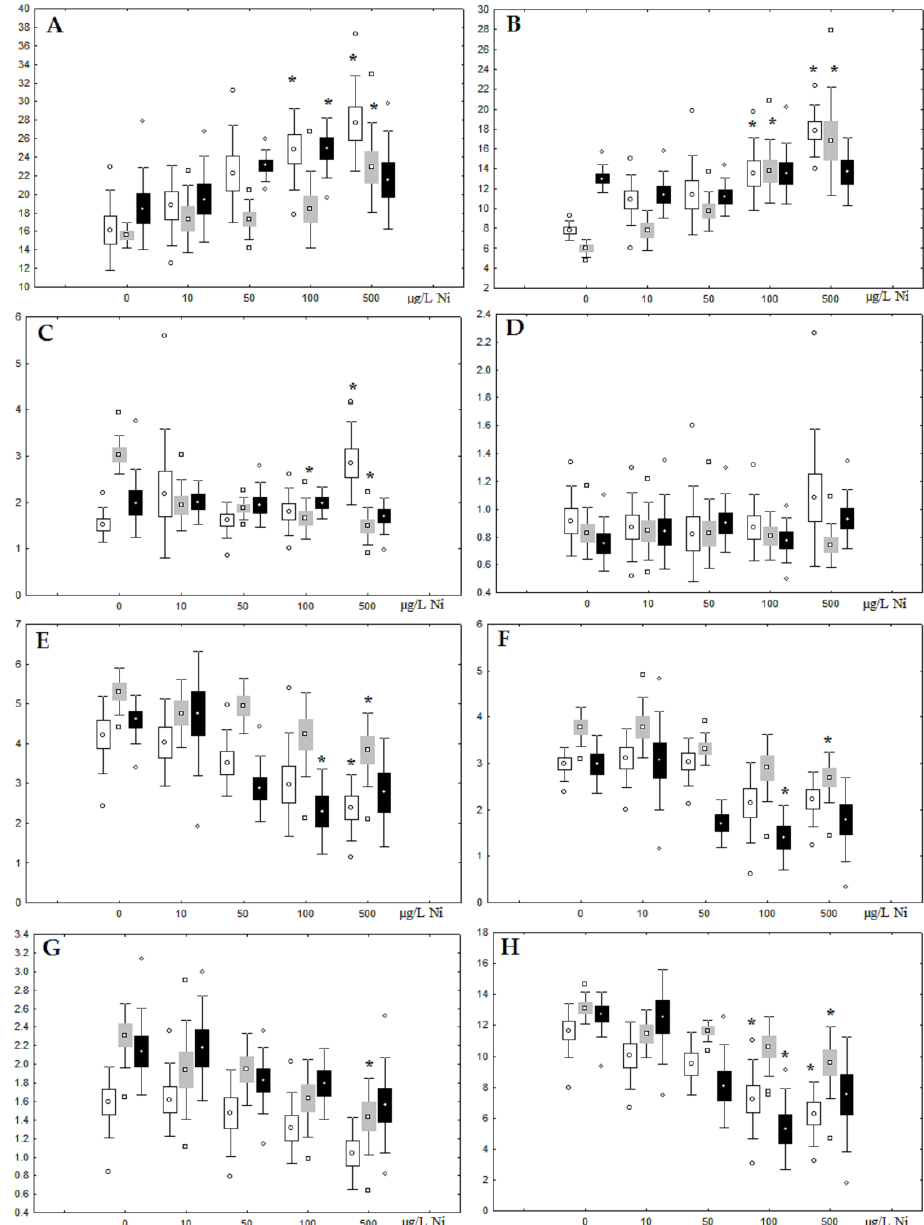
Figure 5. Changes in some dominated fatty acids in phospholipids: ( A ) 16:0, ( B ) 18:0, ( C ) 18:1n-9, ( D ) 20:1n-9, ( E ) 20:5n-3, ( F ) 22:6n-3, ( G ) 18:2n-6 and ( H ) 20:4n-6 in phospholipids of digestive glands of A. cygnea under experimental nickel effects: white box—day 1 of the experiment; grey box—day 3 of the experiment; black box—day 7 of the experiment. *—significant results in comparison with con- trol (0 µg/L Ni). Differences were estimated using the nonparametric Kruskal – Wallis test, p < 0.05.